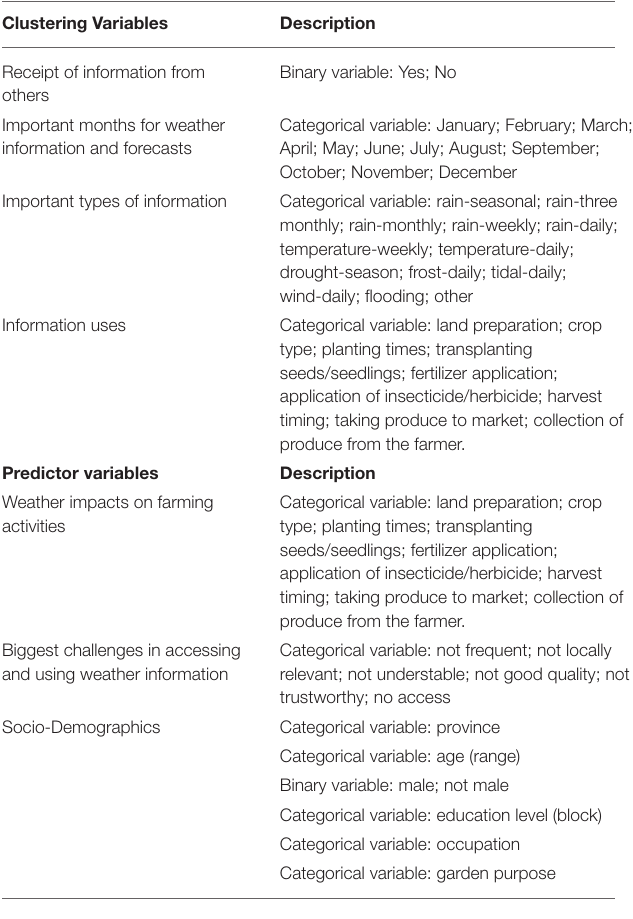
TABLE 1 | Variables used for the study analysis. Clustering Variables